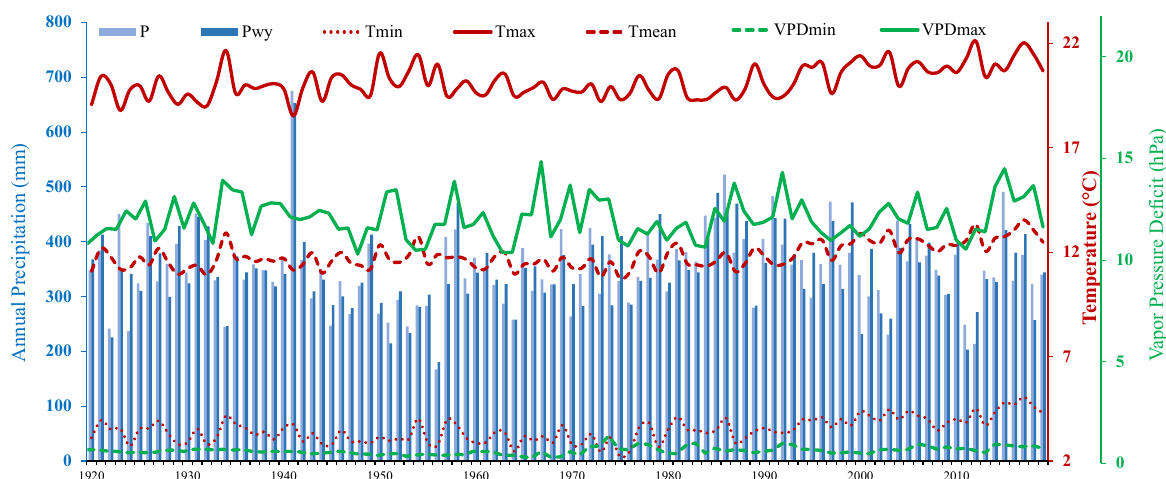
Figure 2. Historical climate variables (annual precipitation (P), annual water year precipitation (P wy ), average min (T min ), max (T max ), and mean (T mean ) temperature) from 1920 to 2019 [55].